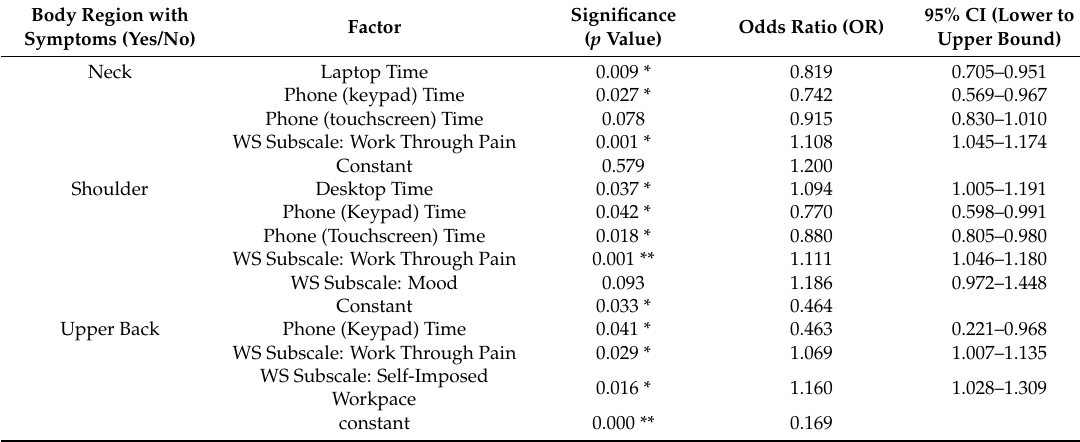
Table 5. Summary of final multivariate logistic regression models for the five major body regions of musculoskeletal symptoms.